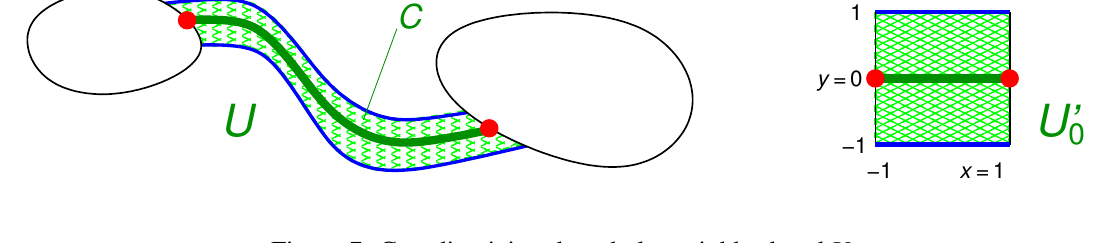
Figure 7: Coordinatizing the tubular neighborhood U .